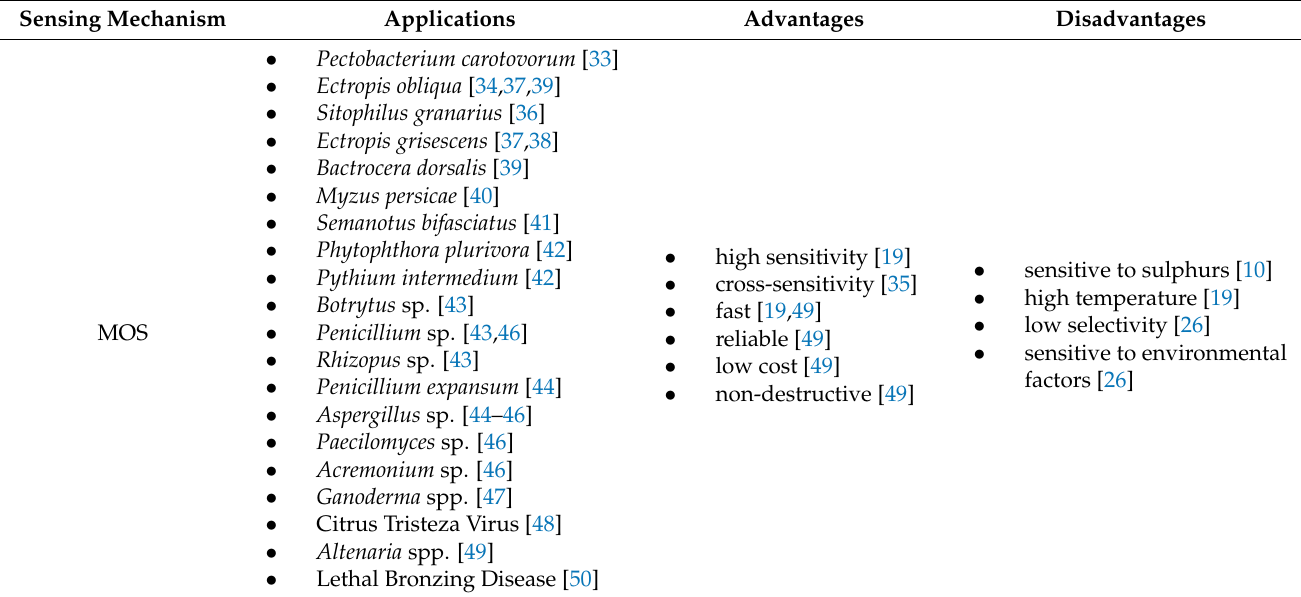
Table 1. Summary of applications, advantages, and disadvantages of gas-sensing methods as reported in the applications discussed in this